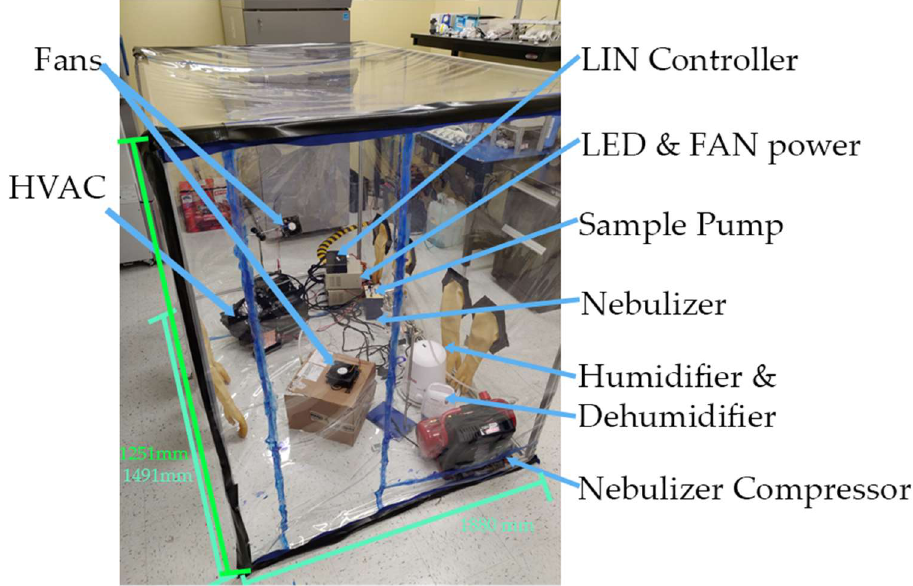
Figure 3. The test chamber with labeled components.